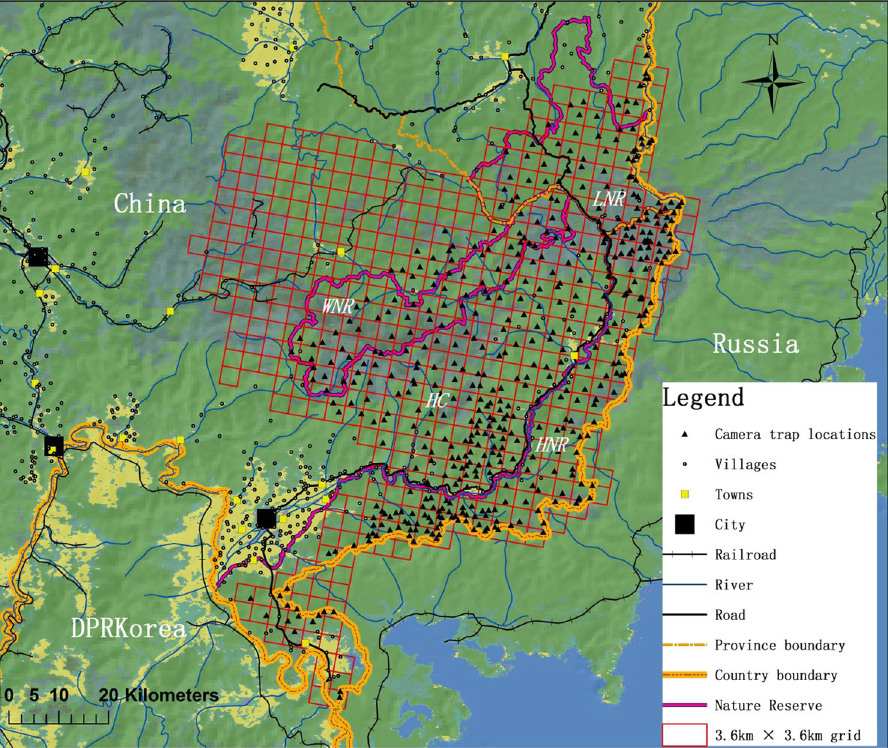
Figure 1. Study area and locations of camera trapping sites in Northeast China. Map was created using ArcGIS software by Esri (Environmental Systems Resource Institute, ArcGIS 10.1;